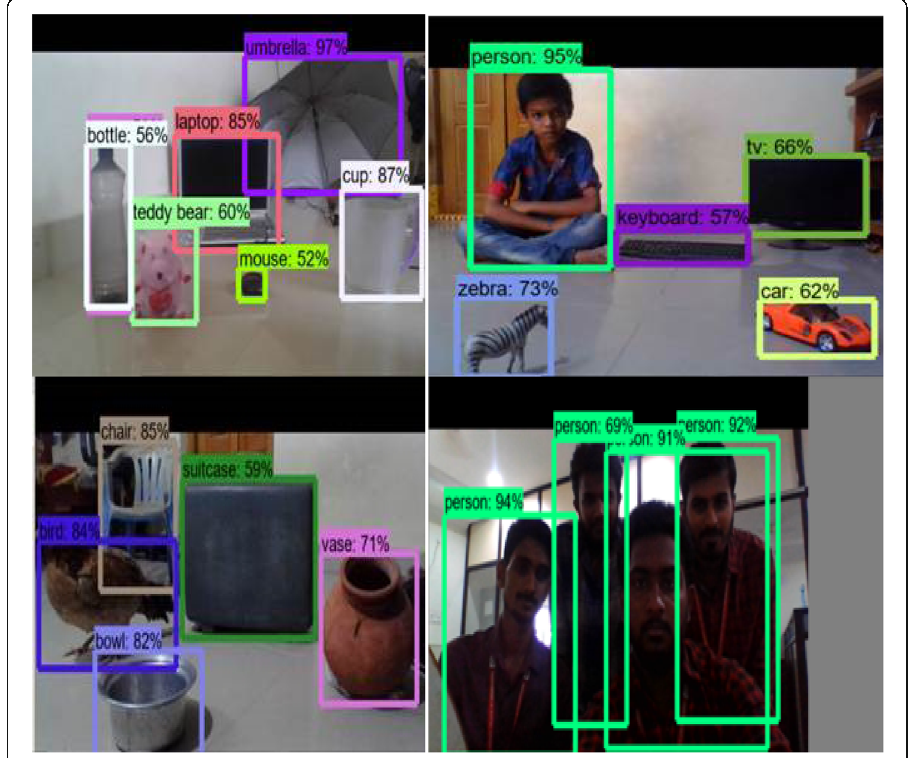
Fig. 7 Detection of objects with different boxes using proposed approach. Represents the various objects detected by the proposed algorithm. We have used different colors of boxes to show different class labels. Our scheme correctly detects and recognizes bottle, laptop, mouse, cup, teddy bear, umbrella, person, keyboard, TV, zebra, toy car, bowl, chair, bird, vassal, and